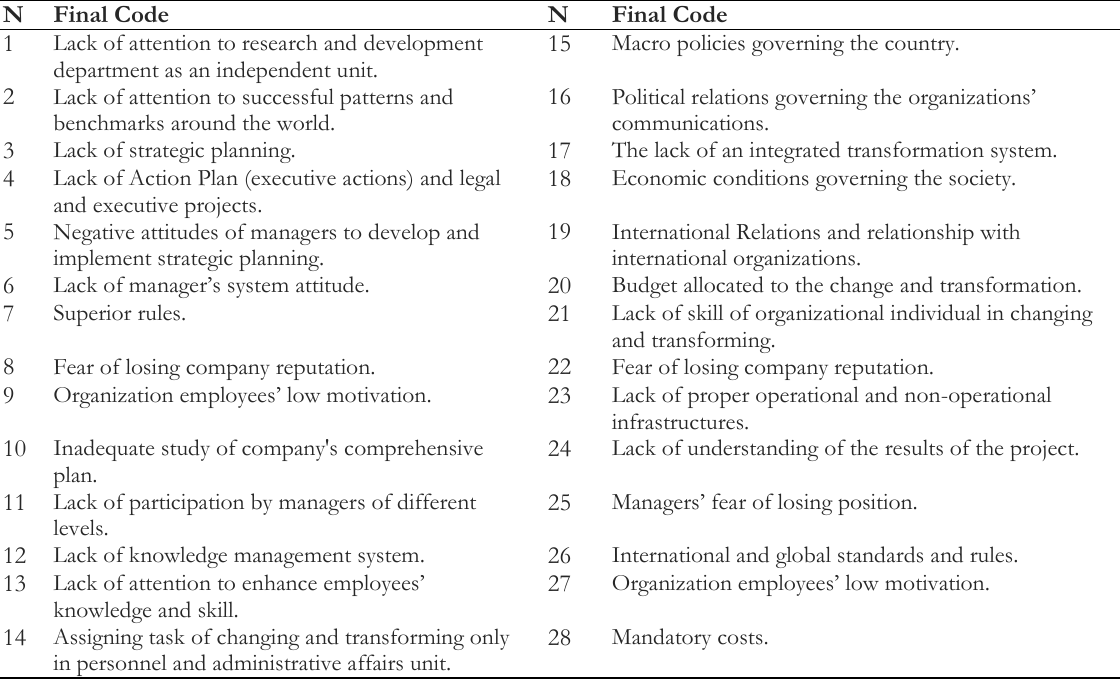
Table 5. Final codes related to